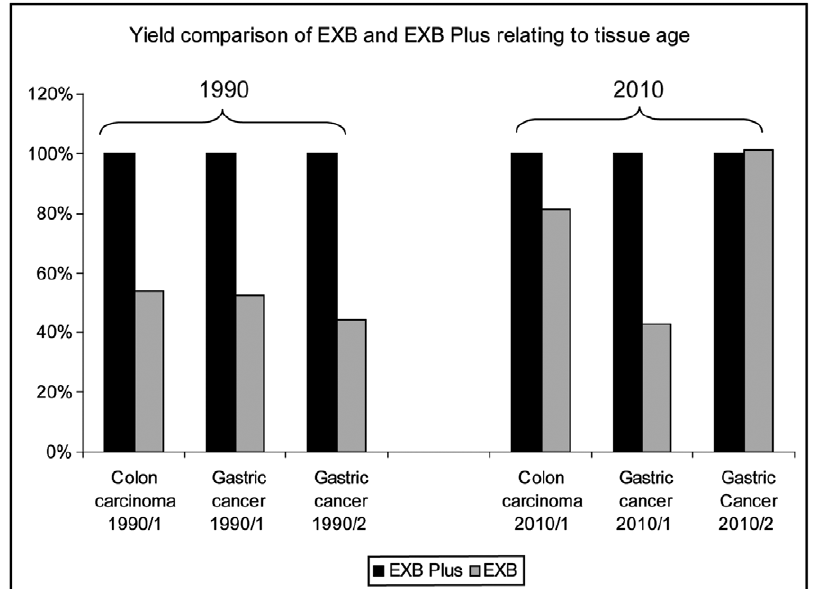
Figure 6. Protein extraction from FFPE samples from 1990 in comparison to samples from 2010. For both years the usage of EXB Plus resulted in higher protein yields compared to EXB but for the twenty years old samples the difference was more striking.